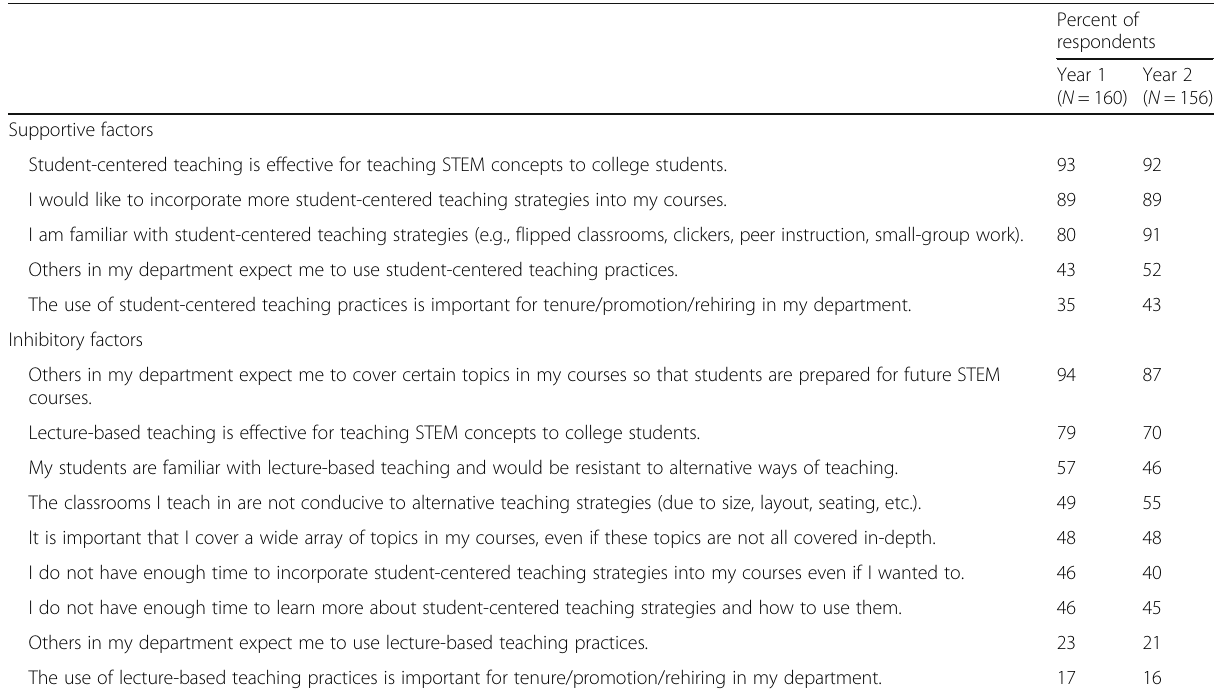
Table 5 Percent of faculty respondents agreeing with various statements about the use of student-centered teaching practices, by